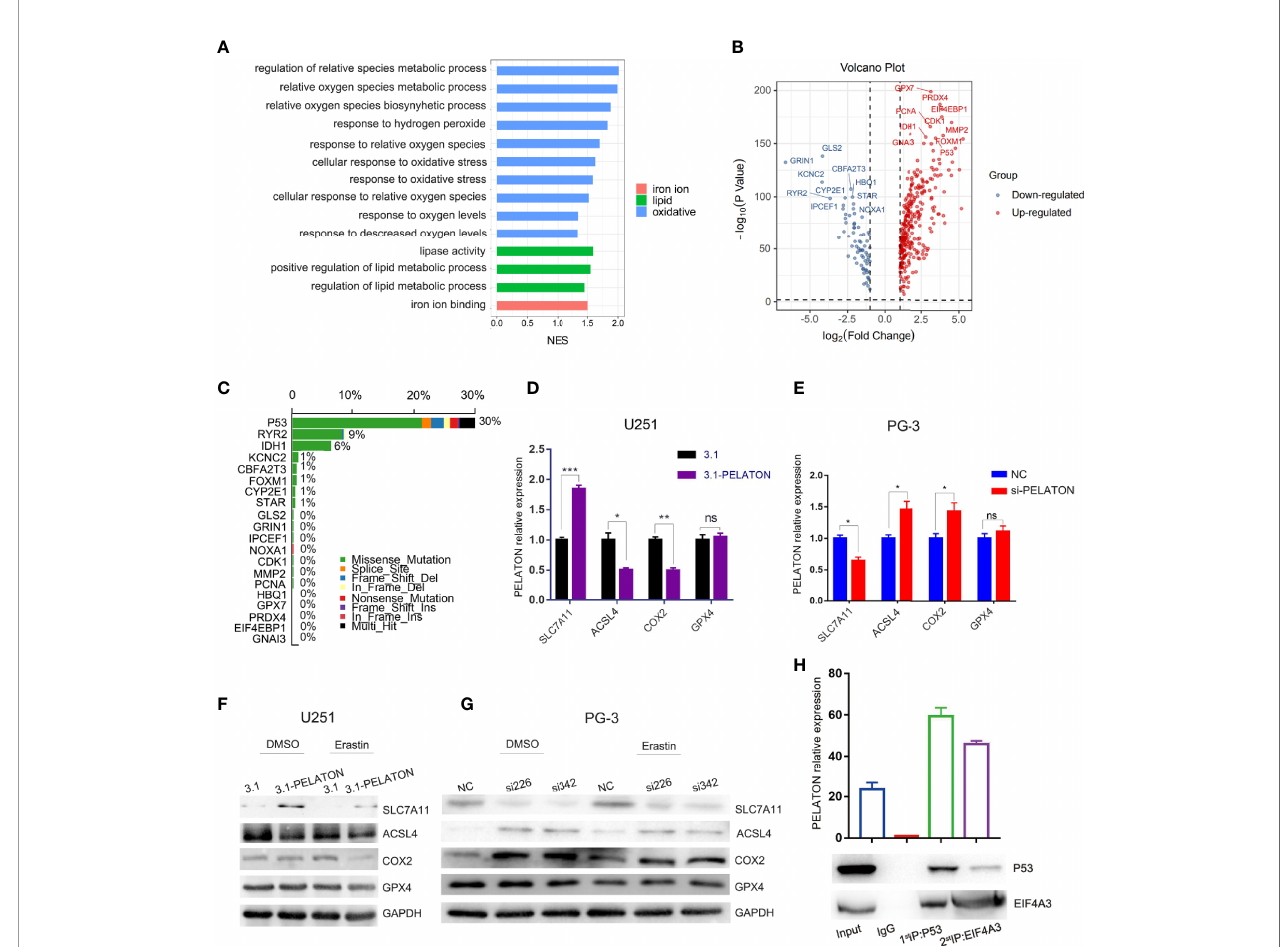
FIGURE 3 | PELATON in the ROS-mediated ferroptosis pathway by mutant p53 . (A) GO analysis of biological processes related to PELATON in GBM. (B) Top 20 genes involved in ROS biosynthesis that are differentially expressed between GBM and normal brain tissue. (C) Gene mutation or overexpression in human GBM. RT-qPCR analysis of ALSL4 , COX2 , SLC7A11 and GPX4 when PELATON was overexpressed (D) or knocked down (E) in glioblastoma cells (*p< 0.05, **p < 0.01; ***p < 0.001; ns, not signi fi cant). Datas were mean ± SEM for three independent experiments. western blot analysis of ALSL4, COX2 , SLC7A11 and GPX4 when PELATON was overexpressed (F) or knocked down (G) in glioblastoma cells. independent experiment was repeated for three times. (H) . The PELATON - EIF4A3 - P53 complex was detected by two-step immunoprecipitation and RT – PCR, Datas were mean ± SEM for three independent